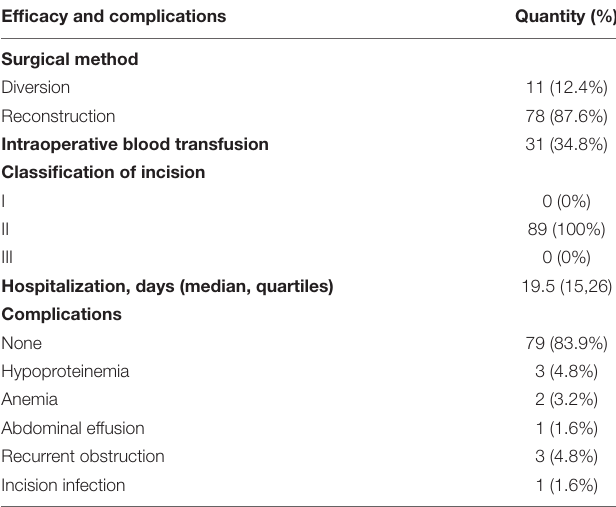
TABLE 2 | Surgical method and complications.